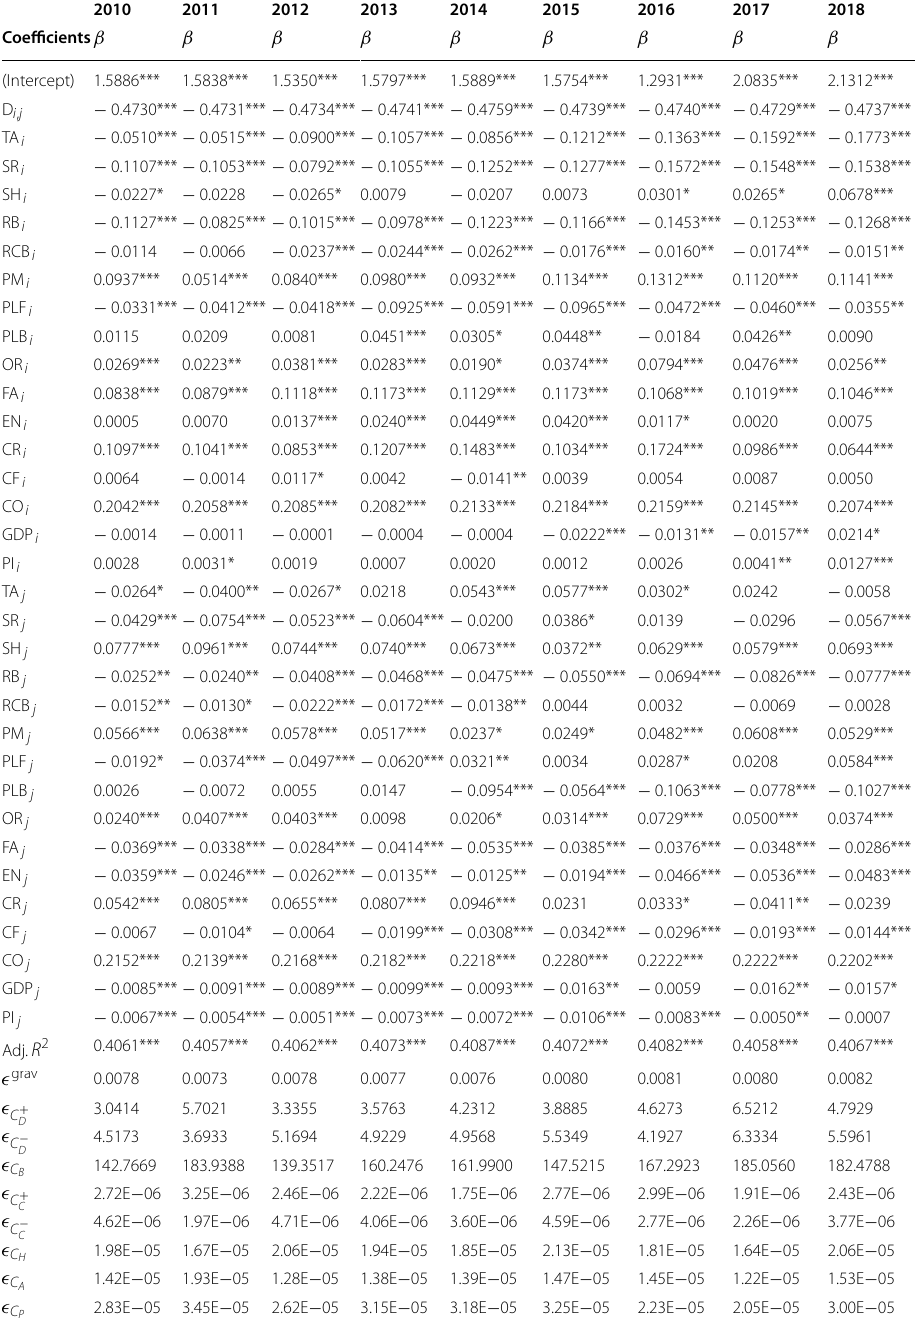
Table 6 Summary table of complete gravity